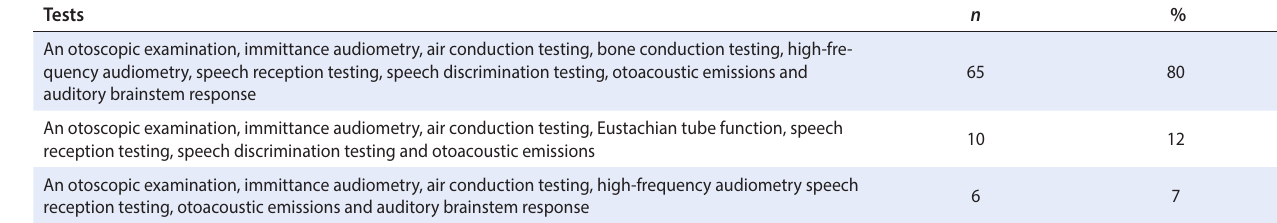
Table 2: Audiological tests used during the baseline assessment ( n = 81)